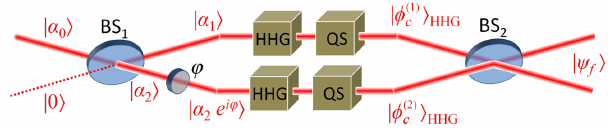
FIG. 14. An optical arrangement that leads to the entangled coherent state | ψ f (cid:2) . Here | α 0 (cid:2) is the initial coherent state of the driving IR field; | α 1,2 (cid:2) are the coherent states after the beam split- ter BS 1 ; | α 2 e i ϕ (cid:2) is the state of the field after the phase shifter that introduces a phase ϕ in | α 2 (cid:2) ; HHG and QS are the HHG areas and the QS arrangements; | ψ f (cid:2) is the final state after the last beam ( 1 / 2 ) (cid:2) splitter (BS 2 ); | φ are the optical “catlike” states created c HHG after conditioning on HHG. State | ψ f (cid:2) can be controlled by the variables χ 1 , χ 2 , and ϕ